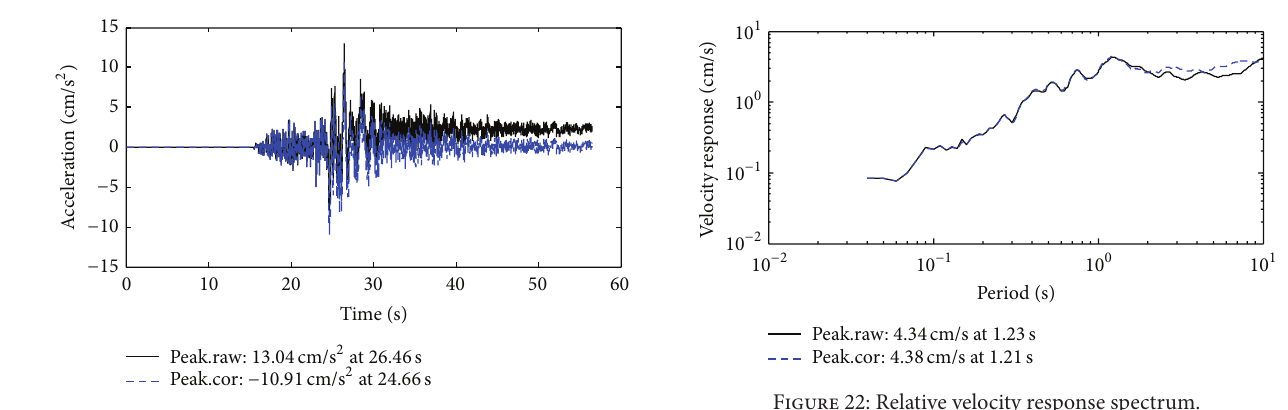
Figure 22: Relative velocity response spectrum.